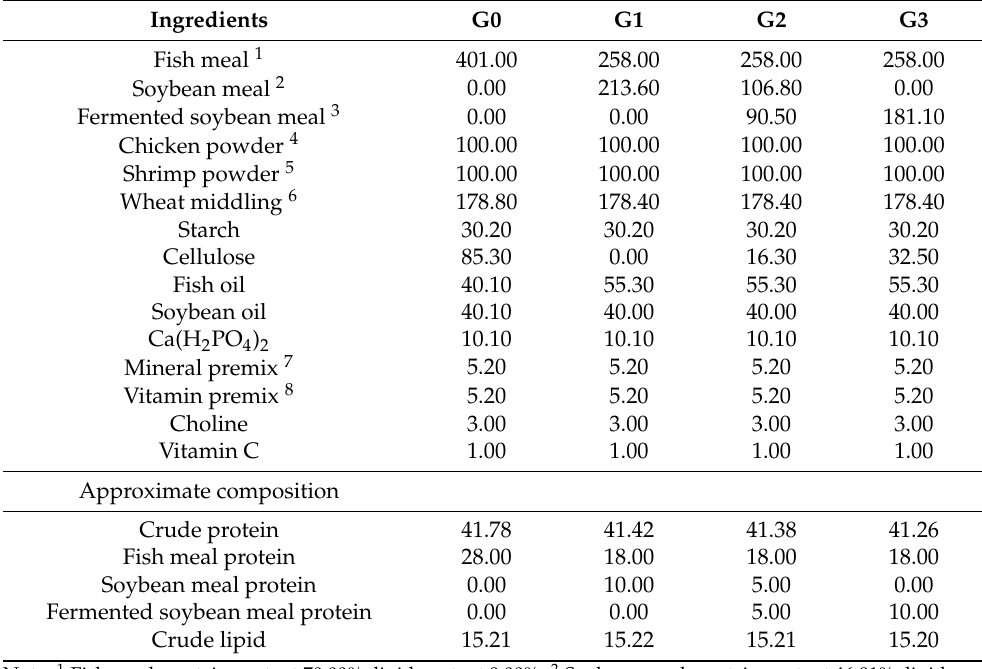
Table 1. Experimental diet formula (g/kg of dried feed) and approximate composition (%, dry matter